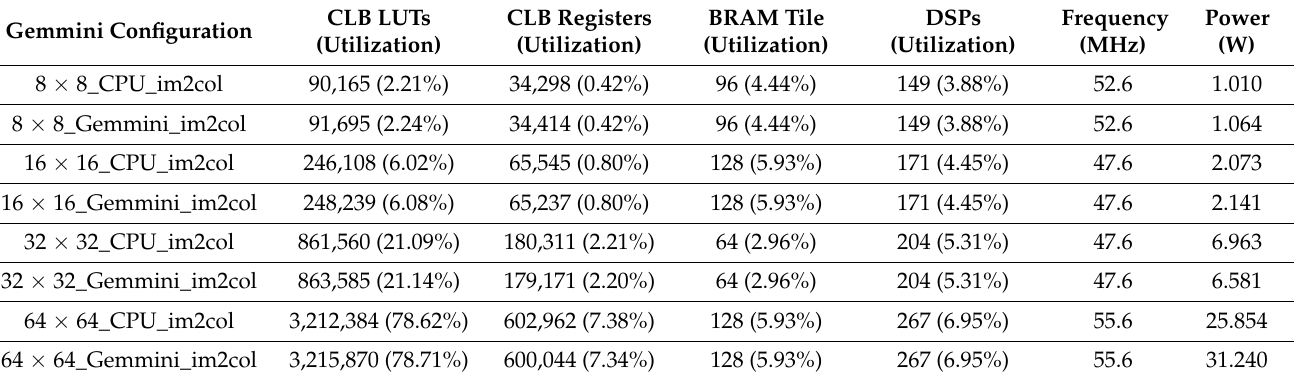
Table 2. Gemmini hardware resource